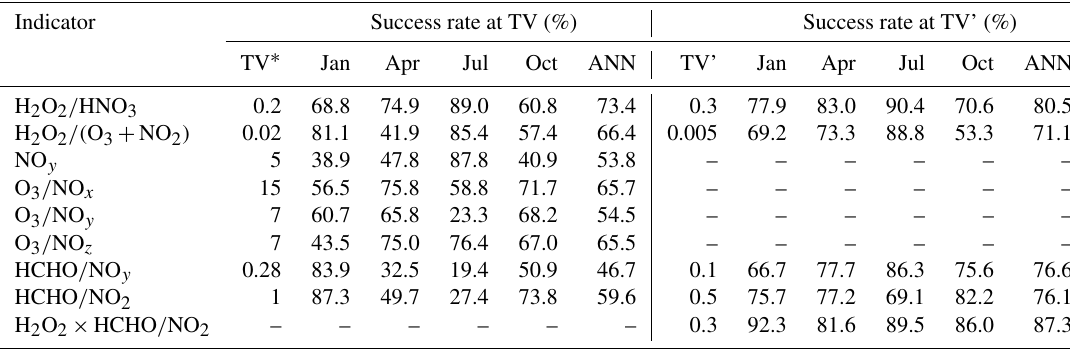
Table 2. Summary of observable indicators and their performances in predicting O 3 chemistry. Indicator Success rate at TV (%)